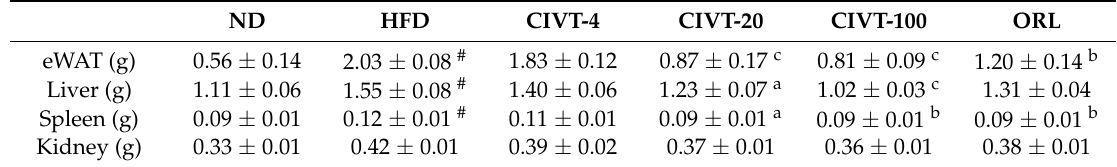
Table 1. Effects of CIVT on organs weight in HFD-fed obesity